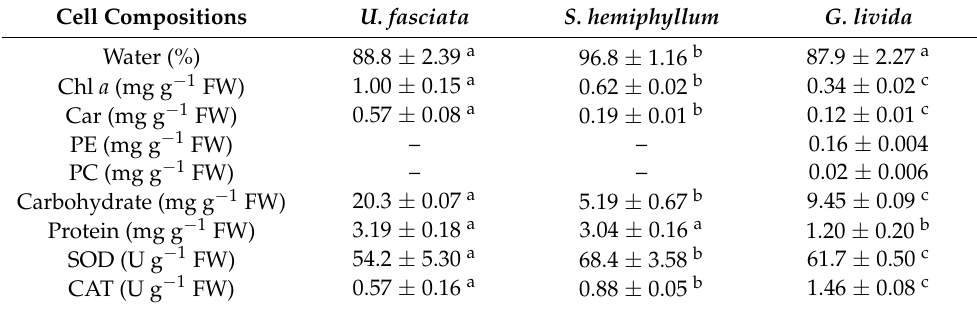
Table 1. Water content (%), biochemical compositions (mg g − 1 FW) of Chl a , carotenoids (Car), phycoerythrin (PE), phycocyanin (PC), carbohydrate and proteins, and superoxide dismutase (SOD) and catalase (CAT) activities (U mg − 1 protein) of U. fasciata , S. hemiphyllum and G. livida grown in field condition. Numbers show the mean and standard deviations (mean ± sd) ( n = 3); and different letters on top-right of number indicate the significant difference among three algae species ( p < 0.05). Cell Compositions